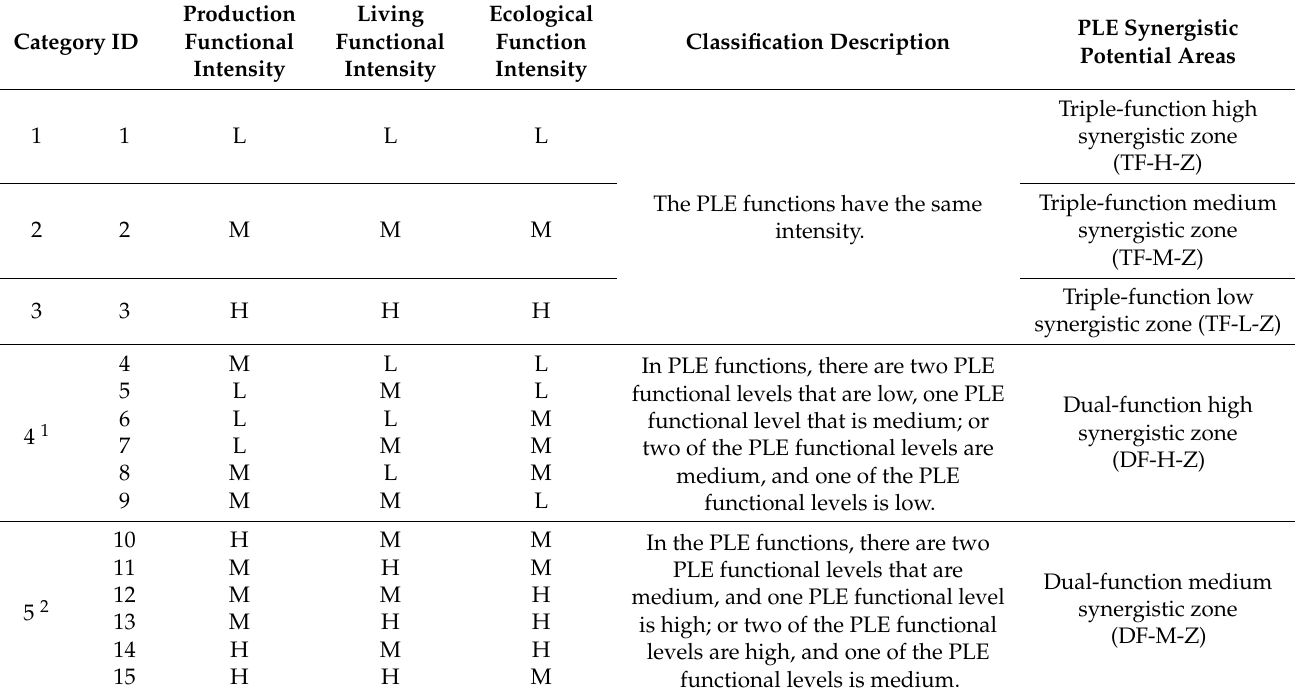
Table 4. Classification evaluation of PLE functions and division of synergistic potential areas of PLE